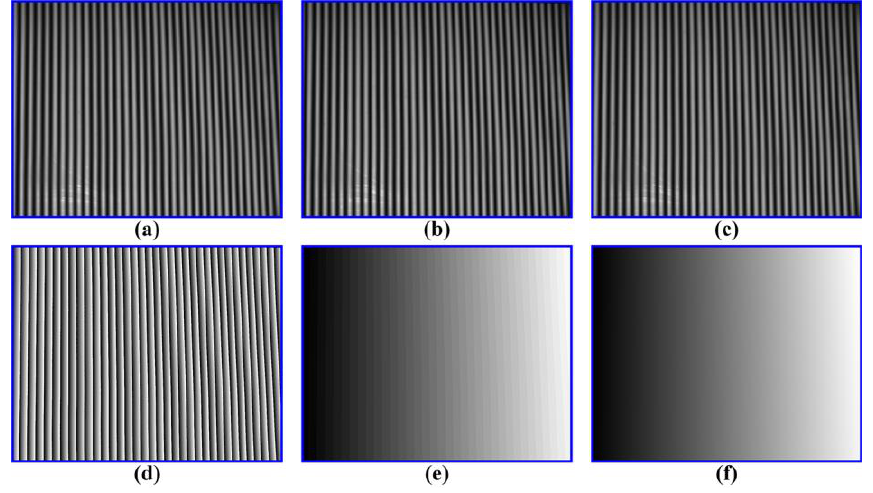
Figure 9. Images of the reference plane. ( a – c ) Phase-shift patterns; ( d ) wrapped phase map; ( e ) minimum fringe order map k min ; ( f ) minimum phase map Ф min .